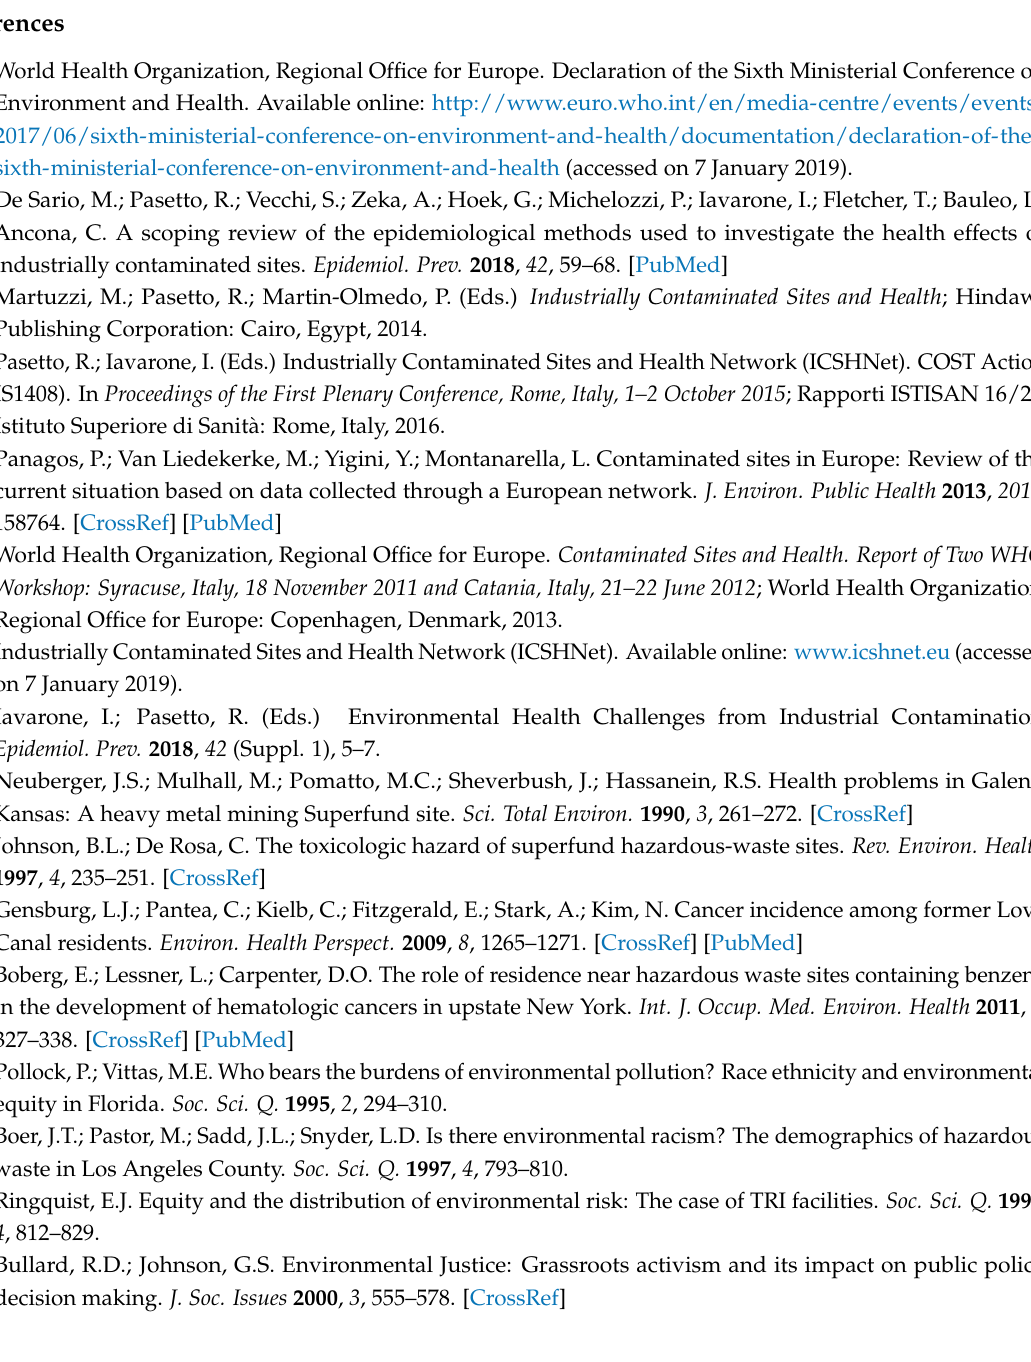
supplementary spreadsheet S1: Main characteristics of studies with eligible abstract within and outside the WHO European